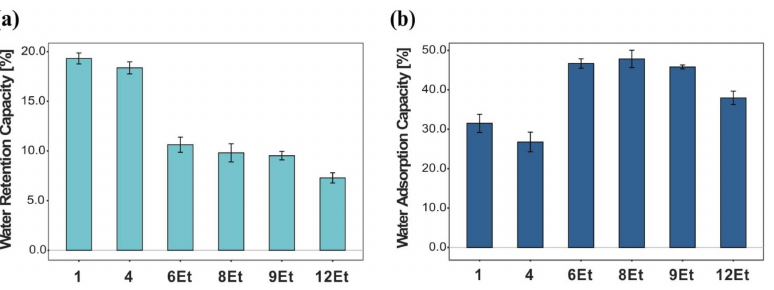
Figure 4. Comparison of the water related parameters obtained for BNC membranes produced by chosen strains. ( a ) Water retention capacity (WRC), ( b ) water adsorption capacity